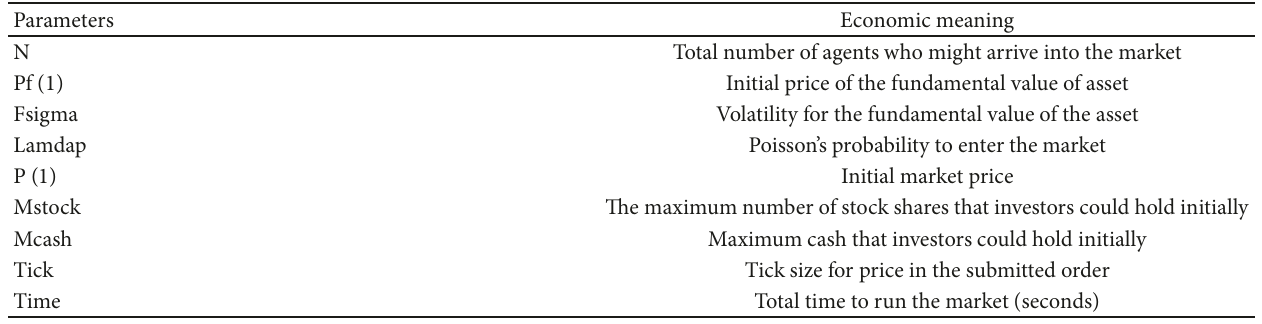
Table 2: Market parameters.